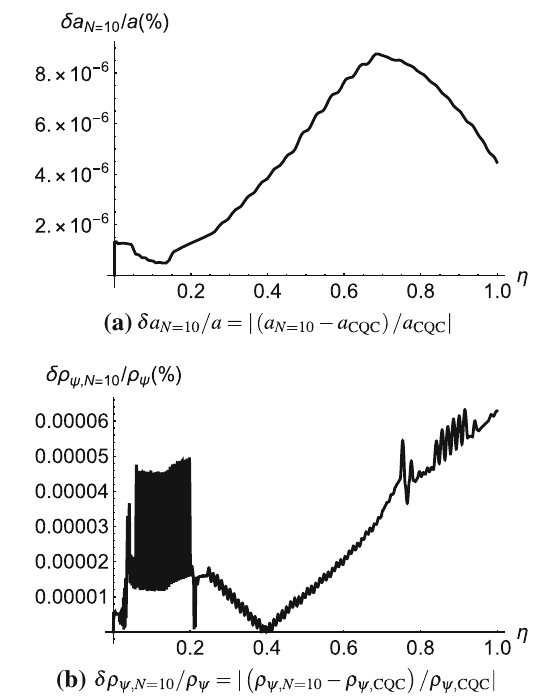
Fig. 8 Relative error between the tenth-order ( N = 10) iterative- perturbative method and CQC for the scale factor, a , and the scalar field’s energy density, (cid:4) 0 | ˆ ρ ( ψ ) | 0 (cid:5) for k = 8 with a 0 = 1 and h = 1